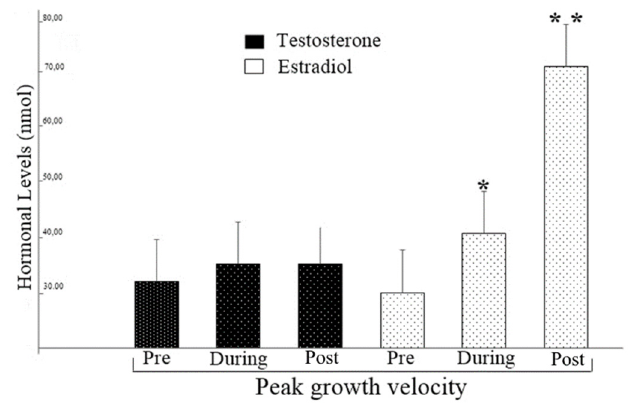
Figure 1. Comparison between groups regarding hormone concentrations. * = Superior to the group Pre peak of the speed of growth; ** = Superior to the Groups pre and during peak of the speed of growth.